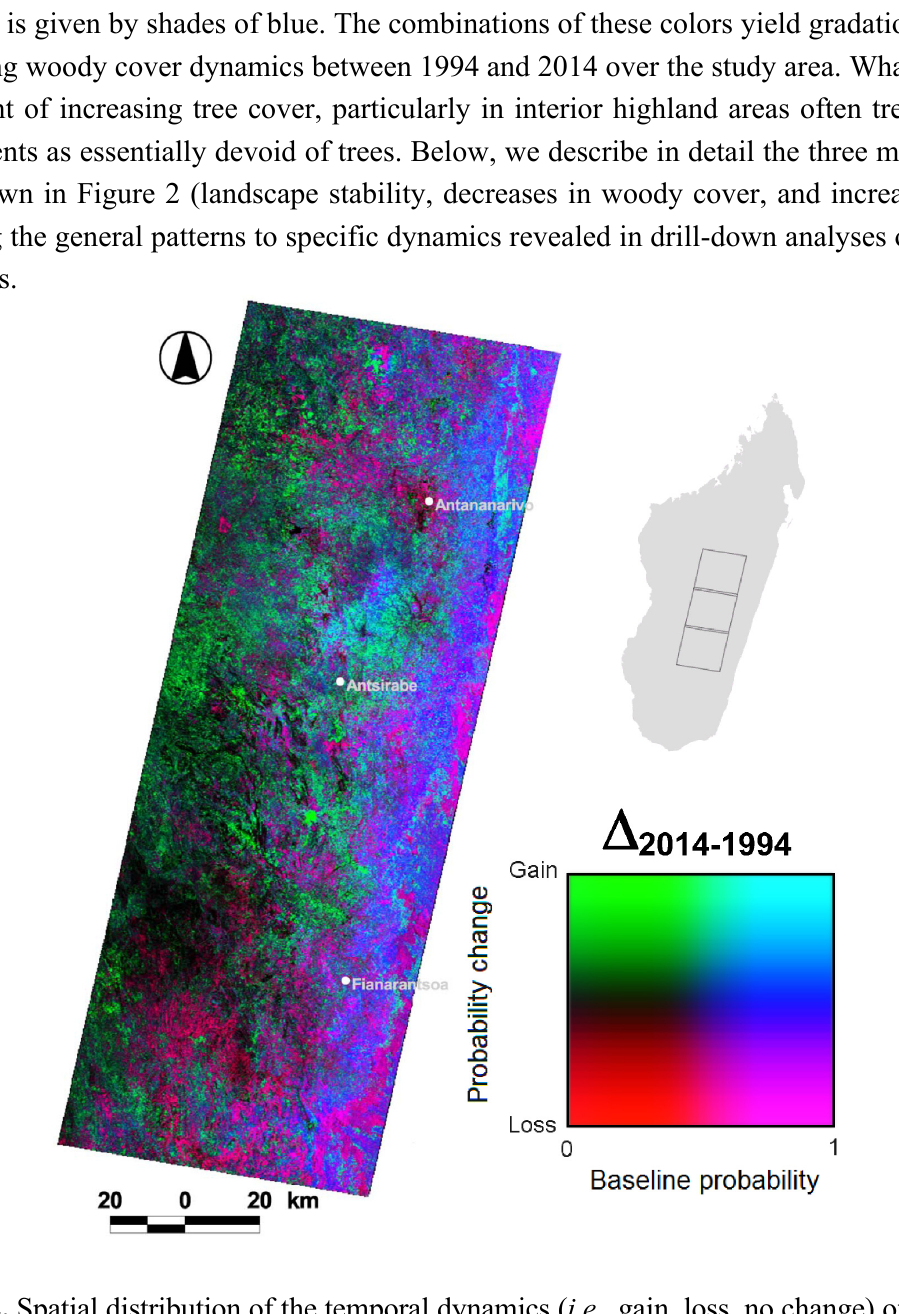
Figure 2. Spatial distribution of the temporal dynamics ( i.e. , gain, loss, no change) of woody cover in the study area over a 20-year period ( i.e. , 1994–2014), as a function of the baseline probability of woody cover ( i.e. , probability of woody cover in 1994). Also shown are the locations of the three major cities (including the capital) in the Highlands of